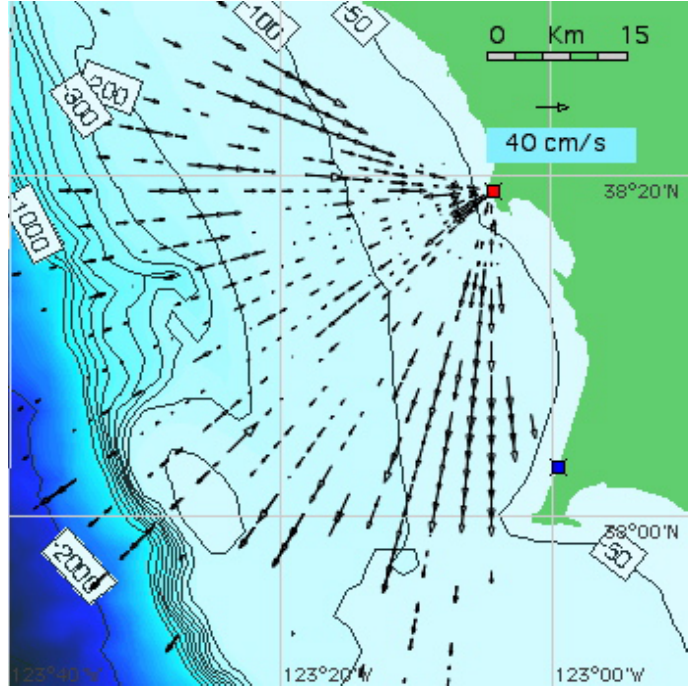
Figure 5. The location of the radar at the Bodega Marine Lab., California, the offshore bathymetry and a measured radial velocity map. Measured radial velocities are for 11 March 2011, 16:52 UTC, and show the reverse flow generated by the tsunami in the inner range